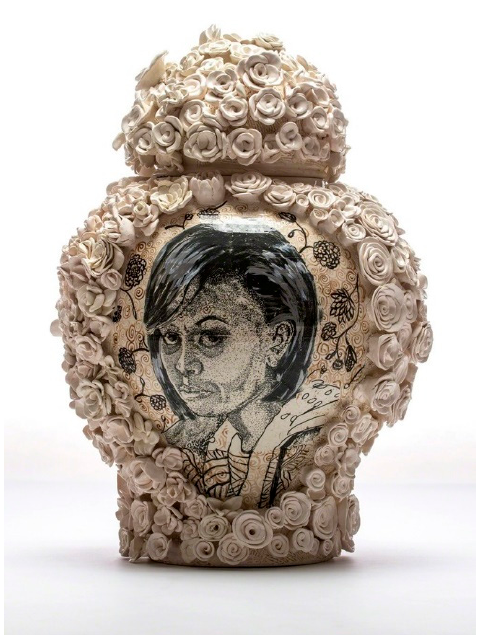
Figure 14. When They Go Low We Go High , 2018 , Porcelain, China Paint, Luster, 25 × 16 × 14 in. Image by KeneK Photography, courtesy of Wexler Gallery.